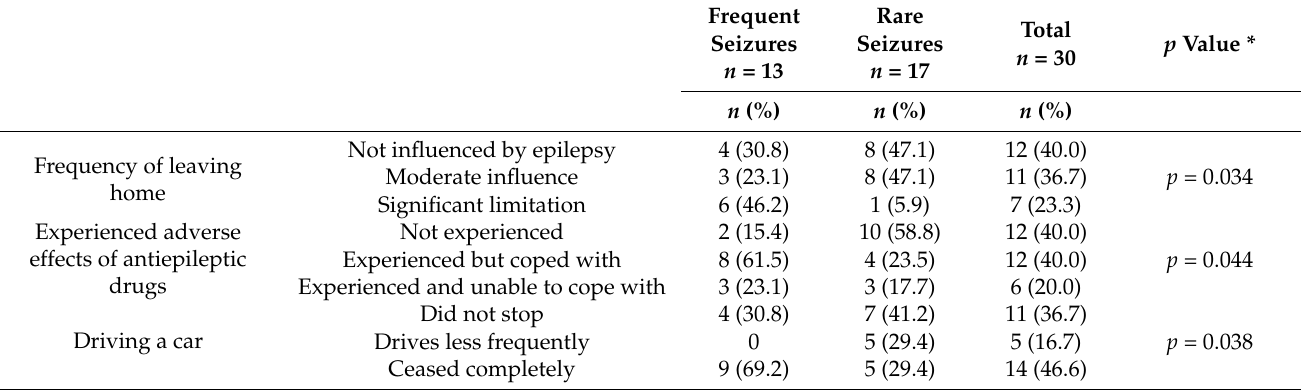
Table 5. Influence of epileptic seizure frequency on selected aspects of functioning in patients with brain